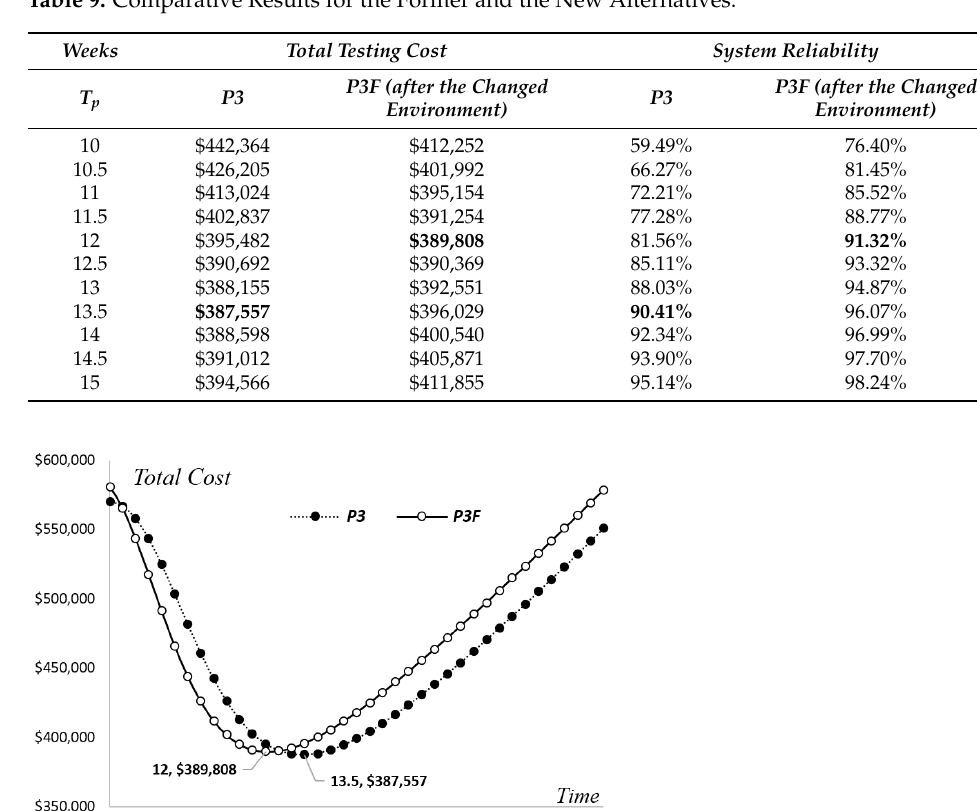
Figure 8. The Detection Rate for the Original and New Alternatives. Table 9. Comparative Results for the Former and the New Alternatives.